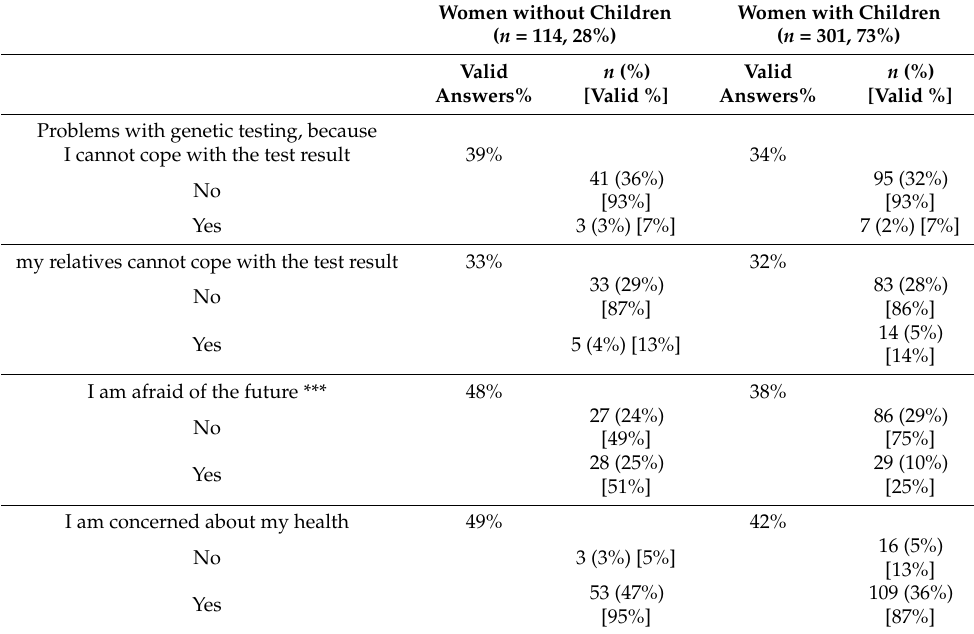
Table 2. Comparison of women with or without children regarding different problems with genetic testing.